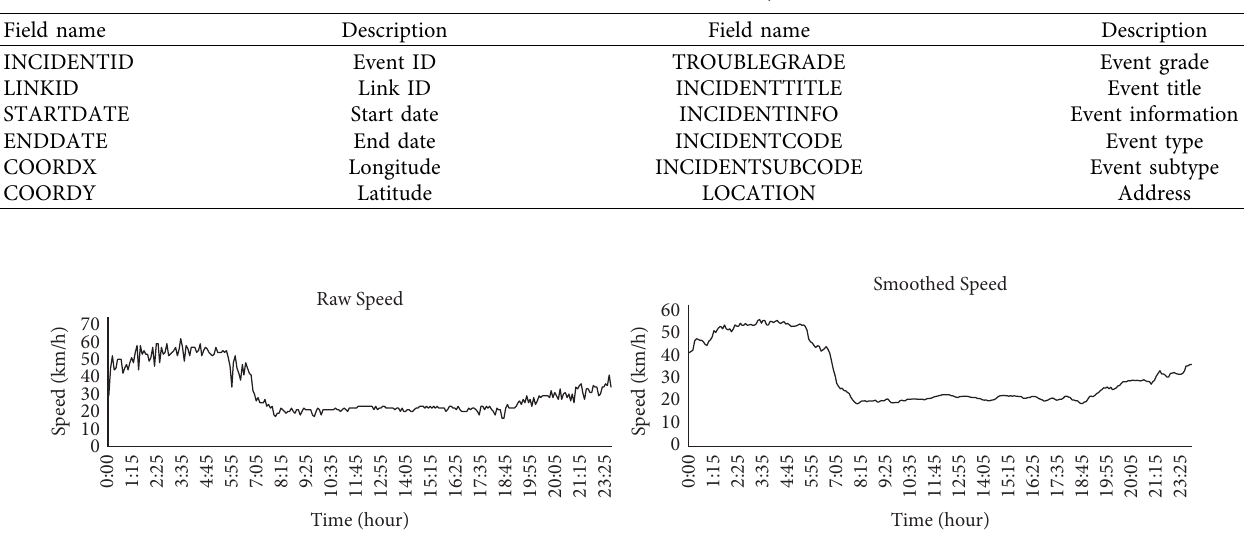
Table 3: Field items of urban traffic information system (UTIS) data.